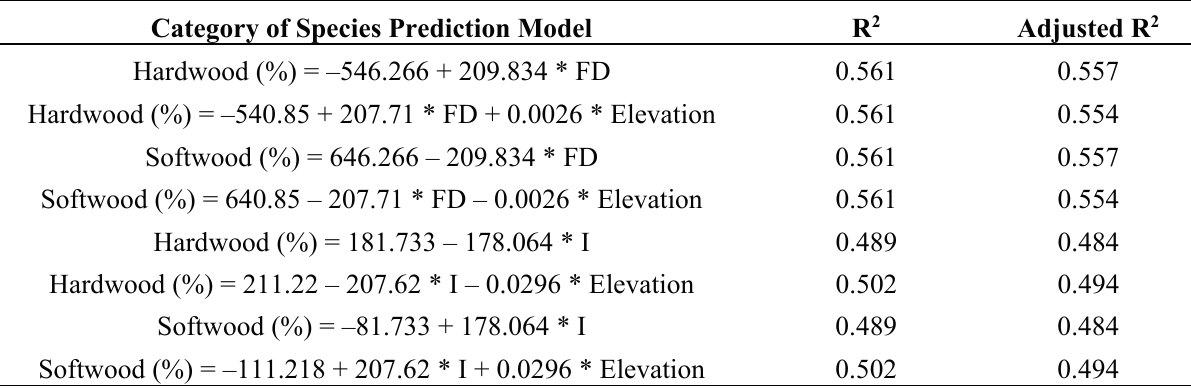
Table 7. Categories of Species Prediction Models.